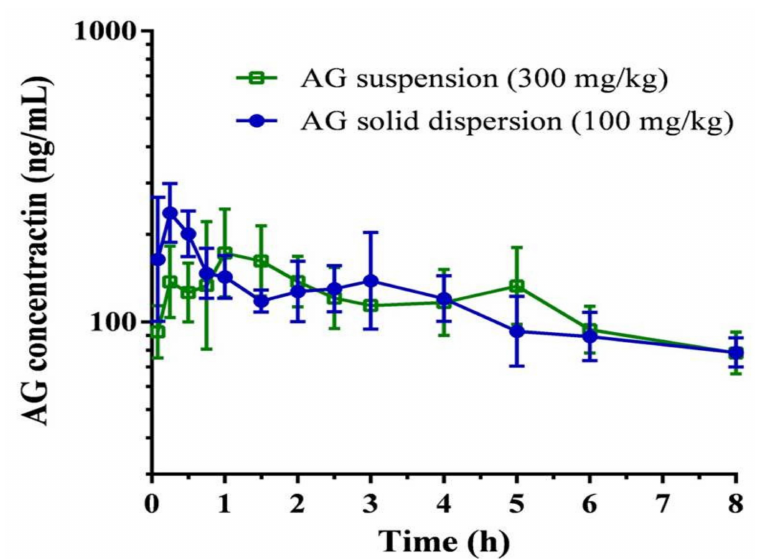
Figure 6. Plasma concentration-time curve of andrographolide (AG) after oral administration of AG suspension and optimized AG-loaded solid dispersion in rats. Data are expressed as mean ± standard deviation ( n = 5 for each group).